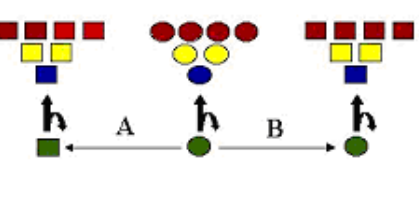
FIGURE 1. Transpotency, a manifestation of adult stem cell pluripotency . Shown are models for tissue turnover units produced by adult stem cells in somatic tissues[25,53]. In each turnover, a single adult stem cell ( green ) cycles with deterministic asymmetric cell kinetics to replace itself while producing differentiating transit cell progeny. ( A) Transdifferentiation. Translocation of an adult stem cell to a different tissue environment may result in changes in the stem cell ( green circle becomes green square ) that lead to the production of transit cell progeny ( squares ) characteristic of the new tissue of residence. ( B) Transpotency. An alternative mechanism to account for “transdifferentiation” is altered instruction of transit cells by the new tissue environment without any fundamental change in the potency of the stem cell. In this way, transpotency is synonymous with stable stem cell pluripotency associated with local instruction of transit cell